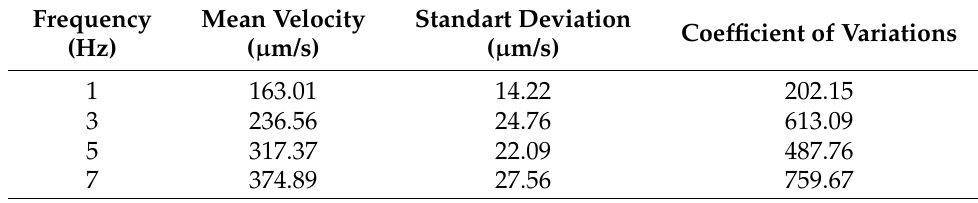
Table 1. Values for the curve fitting line in Figure 3.